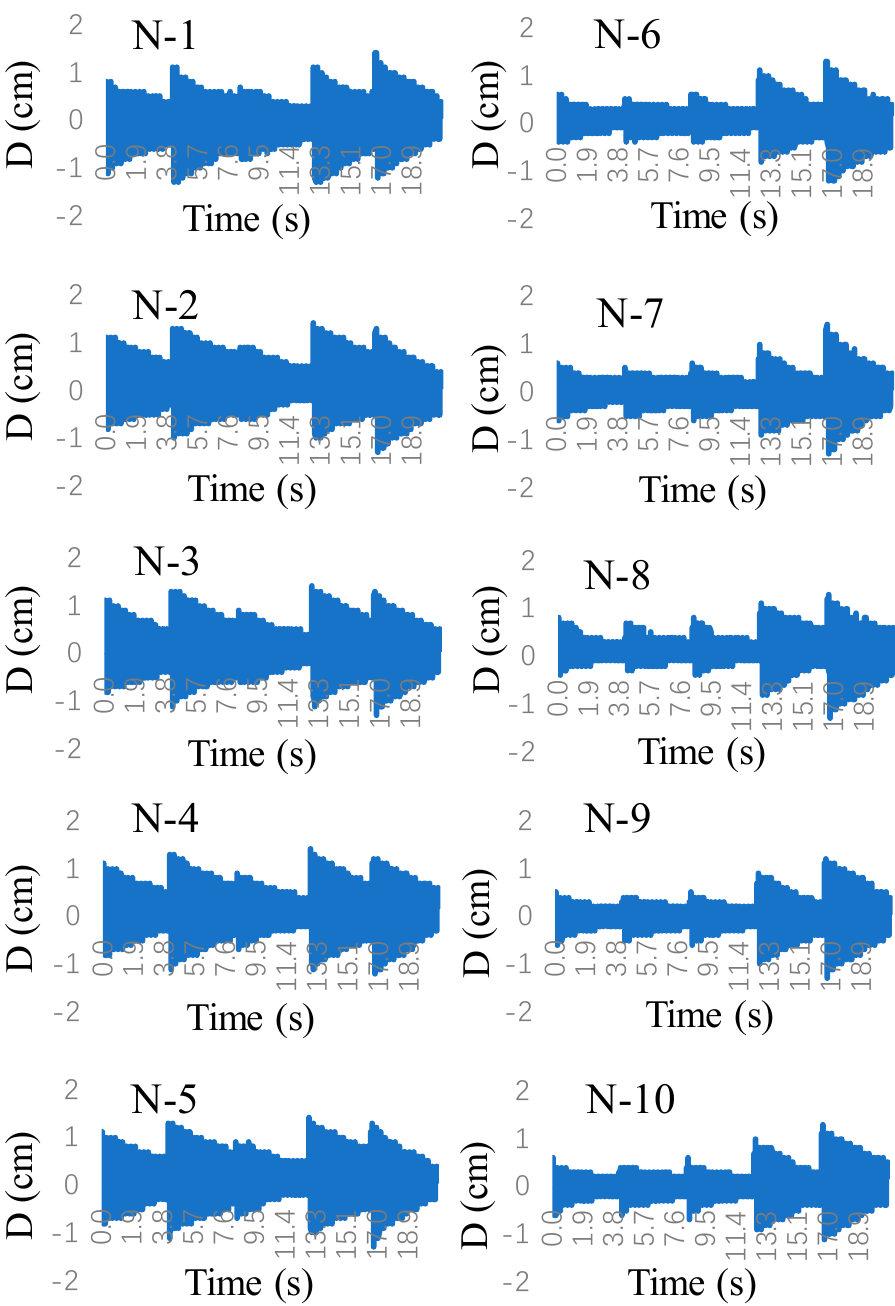
Figure 9. The time-history curve of displacement. D: Displacement. Vibration signals for other damage scenarios are shown in the Supplementary Document. The modal parameters of the structure were obtained by modal analysis of the collected excitation (force), acceleration and displacement signals. Tables 2 and 3 are the first-order natural frequency of di ff erent structural states. Tables 4 and 5 are the modal shape and rotation of di ff erent structural states, and the calculation of rotation was based on the formula [41]: 𝜃 (cid:3036) = −𝜙 (cid:4593) (𝑥 (cid:3036) ) , where 𝑥 (cid:3036) was the location of the node i separating two adjacent elements, i = 1, 2, …, 10. The MSE (Equation (2)) was calculated. According to the MSE of the intact structure and the damaged structure, the MSECR (Equation (3)) was calculated. The MSECR obtained from the data of accelerometer and high-speed camera, respectively, and the results are shown in Appendix B (Tables A1 and A2).